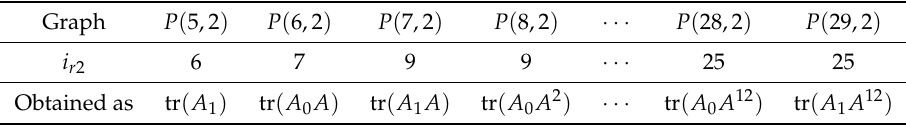
Table 1. i r 2 values for generalized Petersen graphs P ( n ,2 ) .